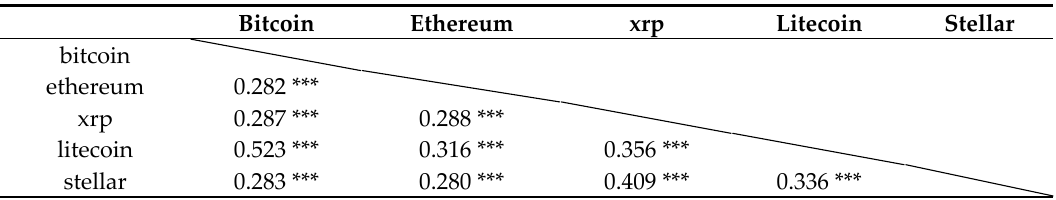
Table 6. Kendall τ parameter for dependence structure.